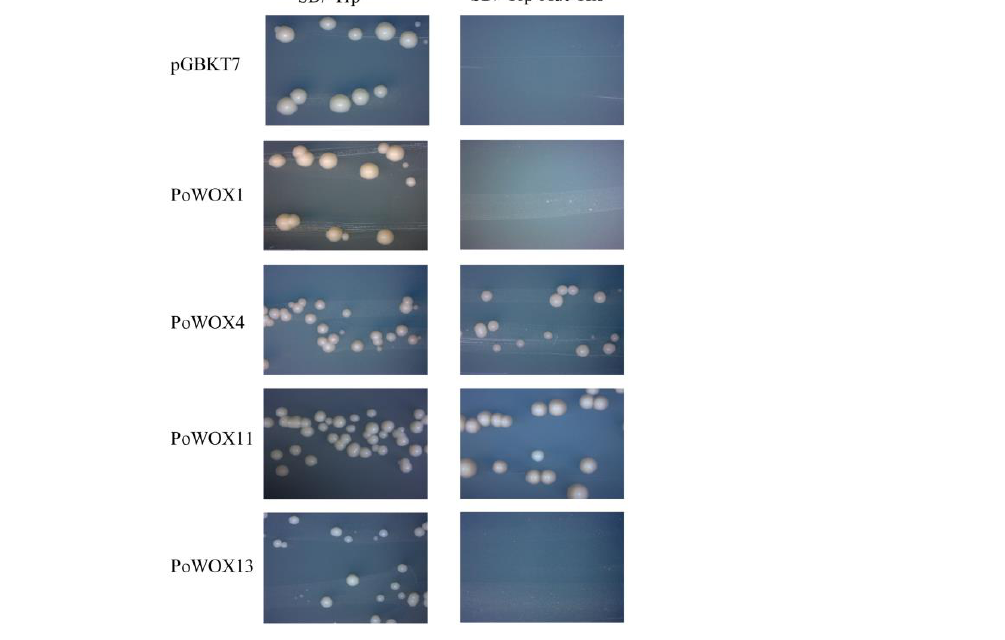
Figure 7. Yeast self-activating analysis. All yeasts grew normally on SD/-Trp plates, and colonies of PoWOX4 and PoWOX11 appeared on SD/-Trp-Ade-His plate. According to the above results, eight combinations of the yeast two-hybrid assays were performed using PoWOX1 and PoWOX13 as bait and prey, and PoWOX4 and PoWOX11 as prey in two-by-two interactions. All normally growing yeasts on non-selec- tive SD/-Trp-Leu plates showed that all bait vector pGBKT7-WOX and prey vector pGADT7-WOX plasmids were successfully transferred into the Y2H Gold strain (Figure 8). Then, based on the analysis of the growth condition of the co-transformed yeast strains on selective SD/-Trp-Leu-Ade-His/X- α -gal/AbA plates, PoWOX11 could interact as prey to form heterodimers with PoWOX1 and PoWOX13, and PoWOX1 and PoWOX13 could also form homodimers. As a prey protein, PoWOX4 could not form dimers with other PoWOX proteins, and the rest of the combinations did not have direct interactions.